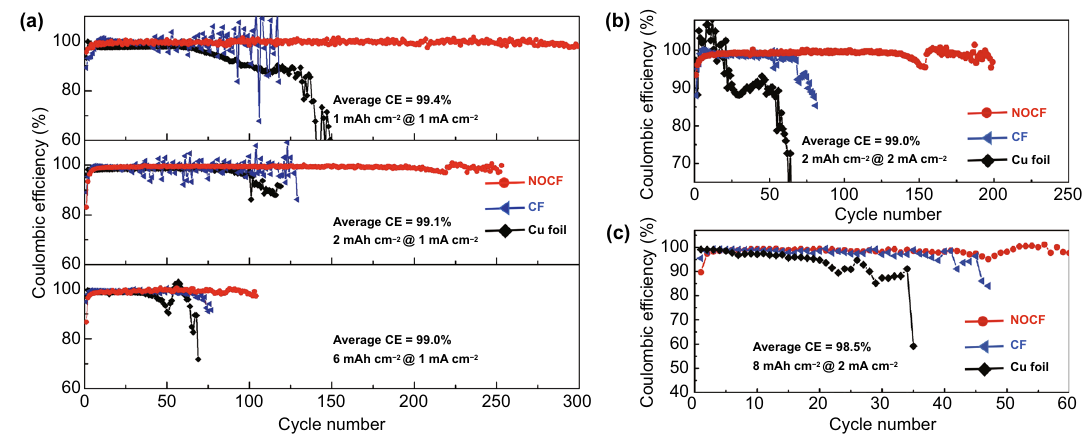
Fig. 3 a Cycling stability of various Li anodes (Li/NOCF, Li/CF and Li/Cu foil) with various areal capacities of 1.0 (top), 2.0 (middle), and 6.0 (bottom) mAh cm −2 at 1.0 mA cm −2 . b , c Cycling stability of various Li anodes (Li/NOCF, Li/CF and Li/Cu foil) with high areal capacities of 2.0 ( b ) and 8.0 ( c ) mAh cm −2 at a high current density of 2.0 mA cm